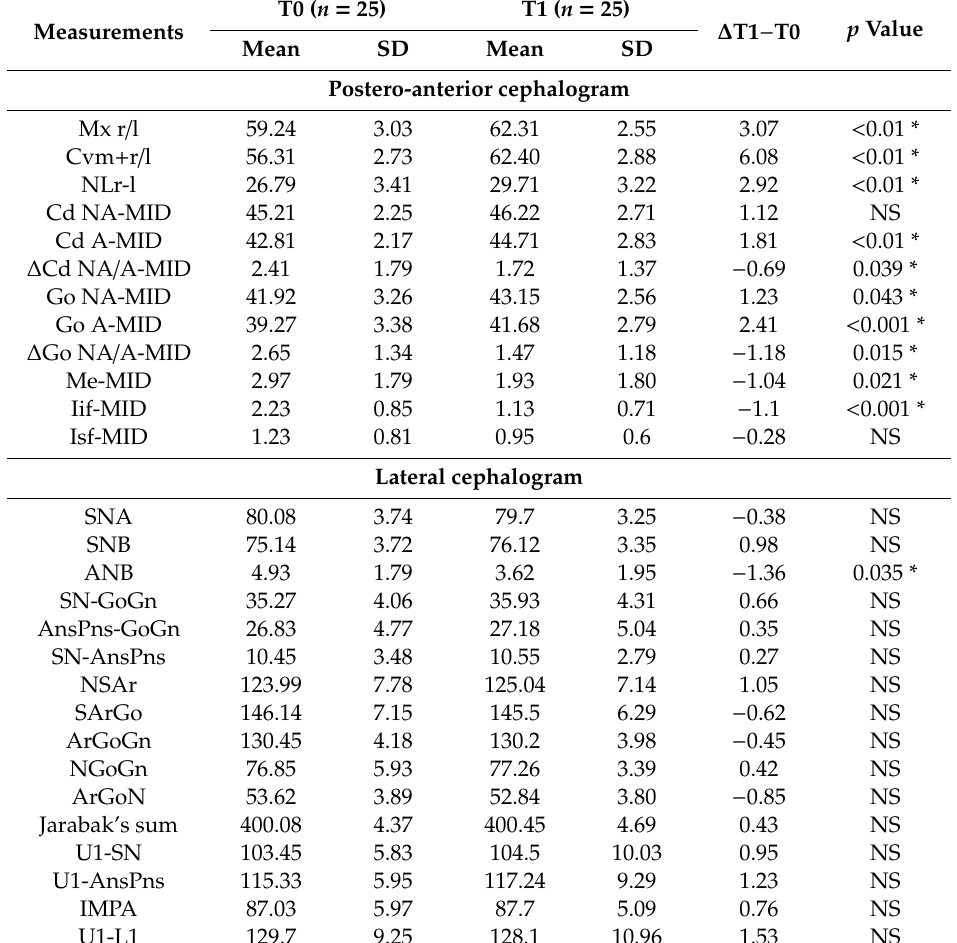
Table 2. Juvenile idiopathic arthritis (JIA) patients. Mean, standard deviation (SD) and comparisons of pre-treatment (T0) and post-treatment (T1) values with paired t-test in patients a ff ected by